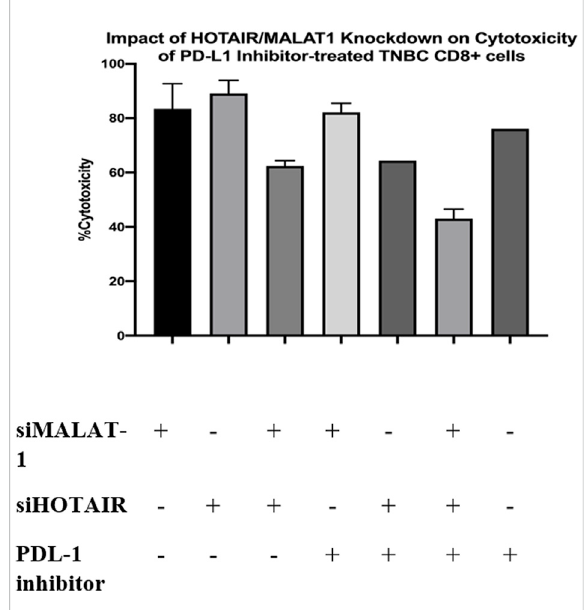
FIGURE 10 Impact of HOTAIR/MALAT1 knockdown on cytotoxicity of PDL-1 inhibitor-treated TNBC CD8 + cells. LDH toxicity assay was performed toassess thecytotoxicity potential ofCD8 + Tcells after culturing in siMALAT1, siHOTAIR, and siMALAT1/siHOTAIR treated TAMs-conditioned media with and without the addition of the PDL-1 inhibitor showing that the cytotoxicity was of higher valuesuponsilencinglncRNAsalonewithouttheadditionofPDL-1